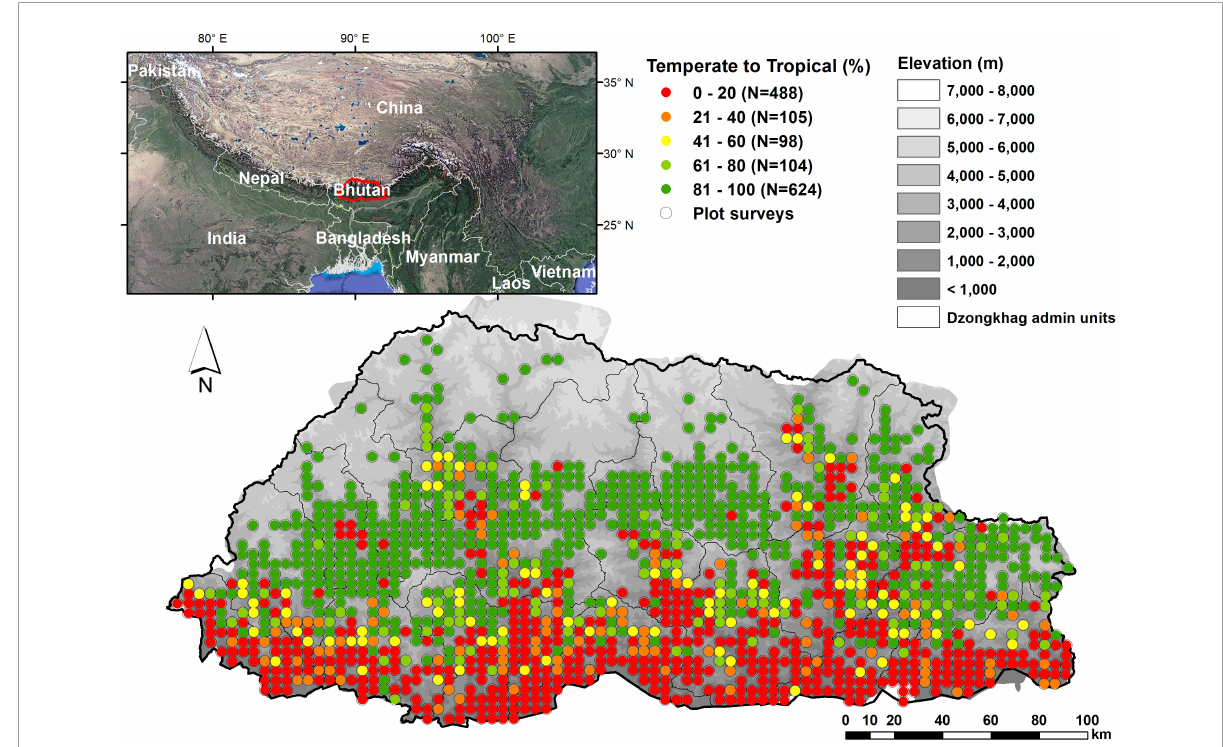
FIGURE1 Study area, location of surveyed NFI plots and percentage of temperate to tropical trees at each plot.